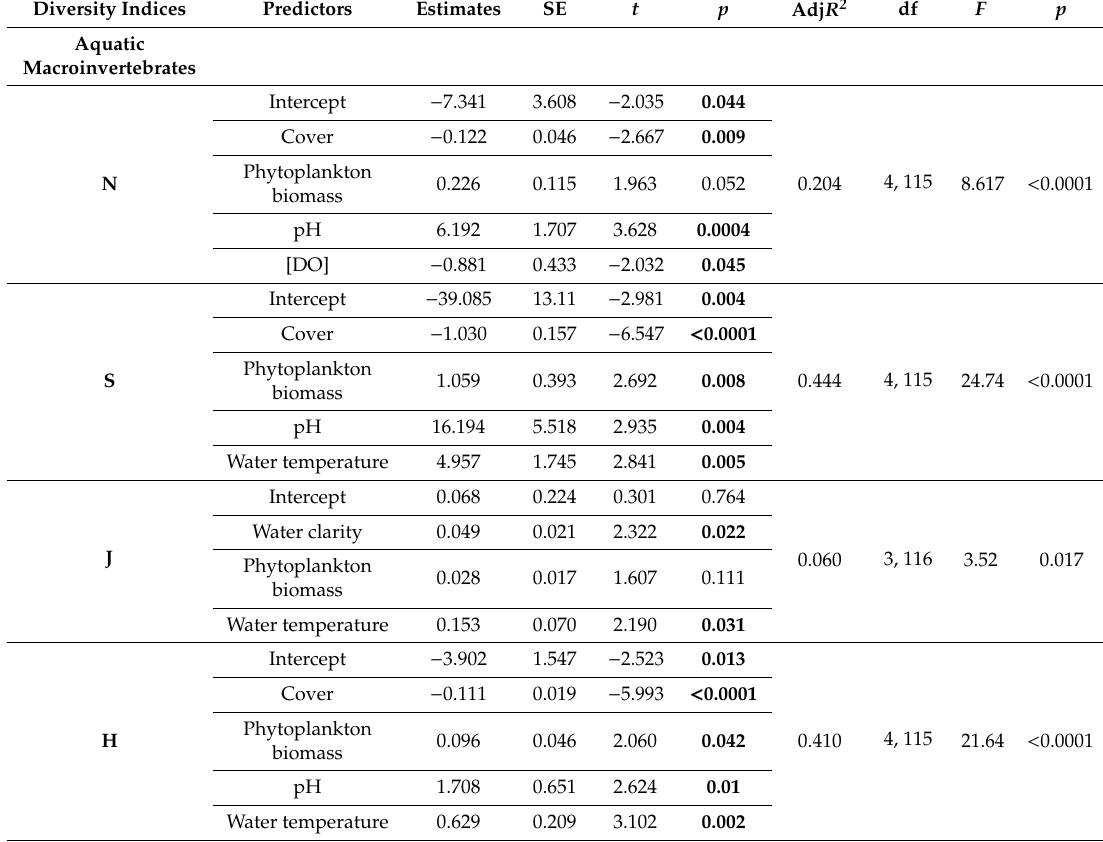
Table 4. Multiple linear regression analyses (summary lm R function) for aquatic macroinvertebrate biodiversity indices. The table shows estimates ± standard error (SE), t -statistics, adjusted R-squared values (Adj R 2 ) and respective p -values for regression coe ffi cients, indicating whether the value of the coe ffi cient is significantly di ff erent from zero ( α = 0.05). Significant di ff erences are in bold. Cover— Salvinia molesta percentage